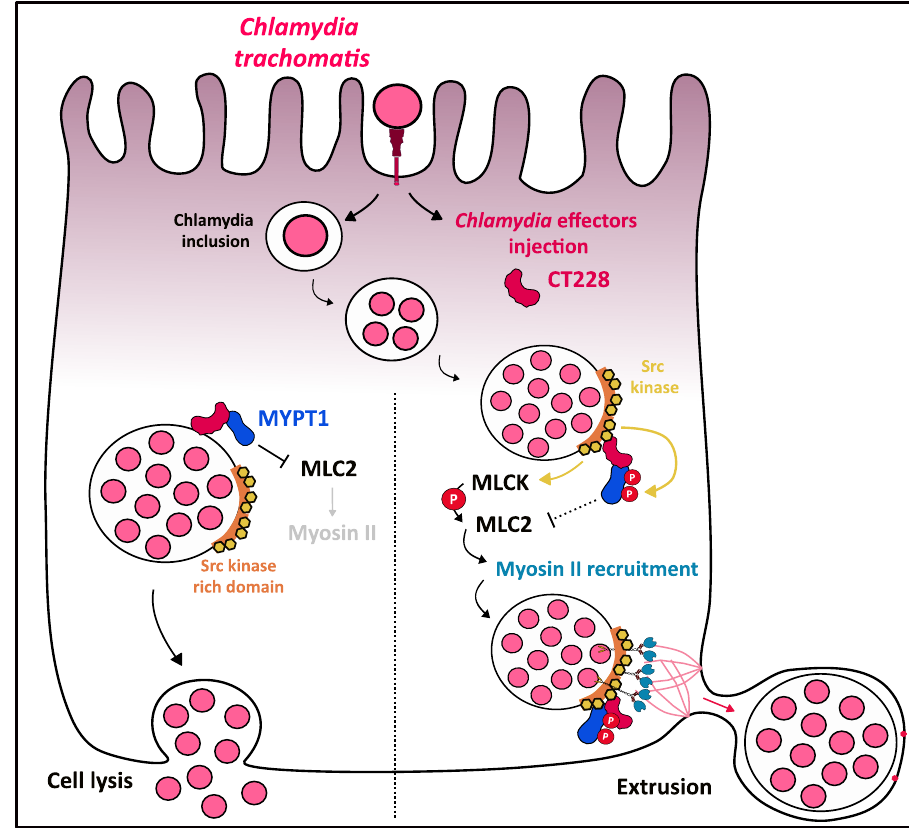
Figure 6. Role of myosin II in C. trachomatis cellular exit by extrusion. After internalization, C. trachomatis efficiently replicates inside a specialized vacuole called inclusion. On the inclusion membrane, Chlamydia effector CT228 is found to colocalize with MYPT1 that is recruited early during infection. The localization and activation status of MYPT1 regulates the cell exit strategy of the bacteria. MYPT1 activated state (non-phosphorylated) is associated with Chlamydia exit through lysis. Extrusion pathway is associated with relocalization of MYPT1 in Src kinase-rich regions on the inclusion membrane in which MYPT1 could progressively be phosphorylated on both inhibitory sites, T696 and T853 by Src kinase and therefore inactivated. This may lead to the MLC2 release from its interaction with MYPT1 and its subsequent availability to be phosphorylated and activated by MLCK, triggering the recruitment of myosin II on Src kinase-rich regions. Myosin II is then used as a tether to walk along the actin to the plasma membrane and create an extrusion.